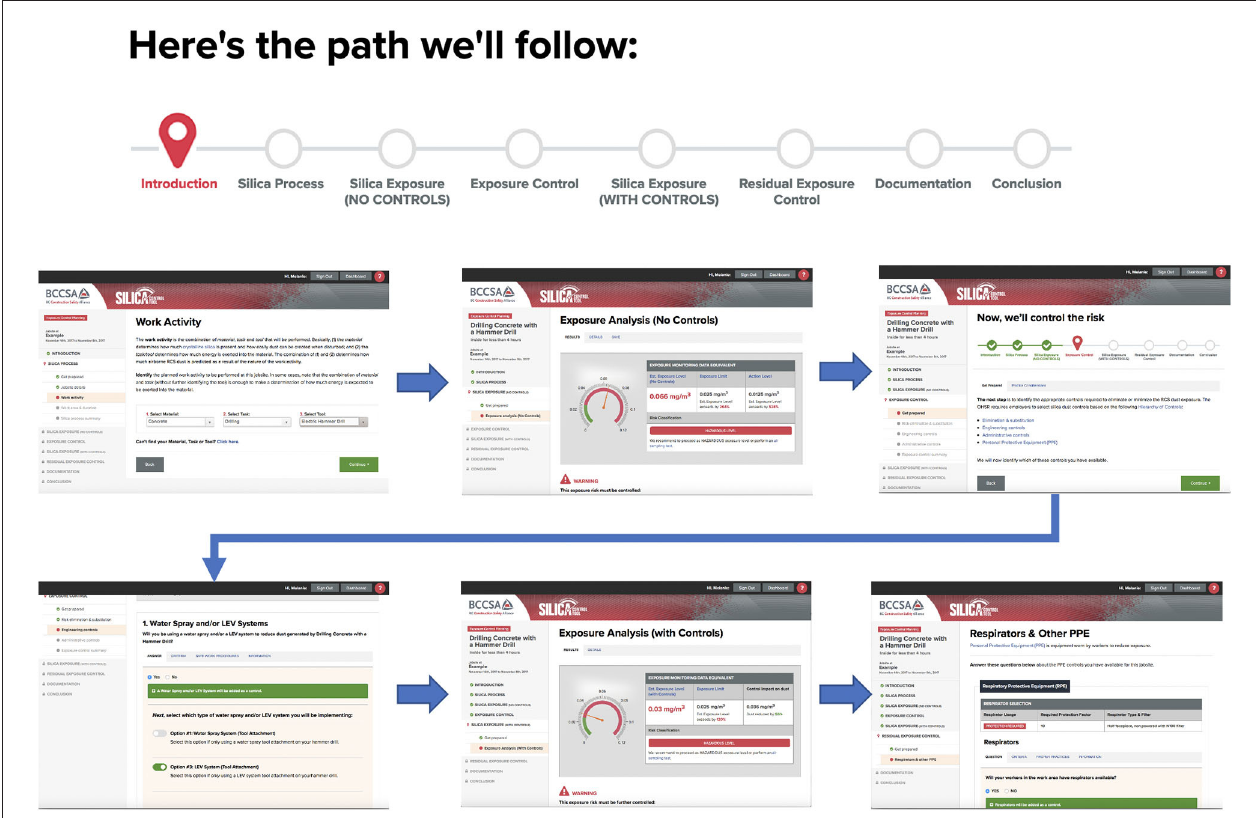
FIGURE 2 | Framework of web-application showing (top) the process flow schematic presented to the user as they progress through generating an ECP; selected screen shots to illustrate design and key steps in session.